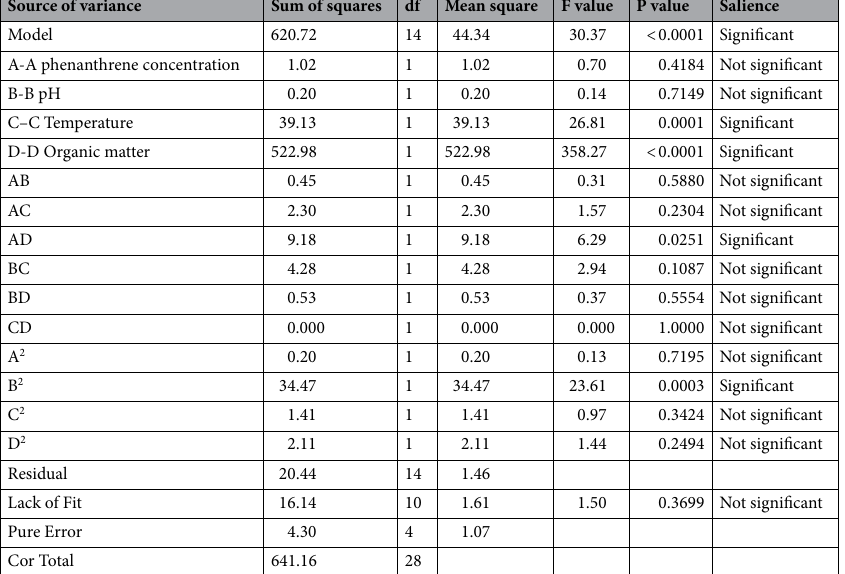
Table 8. Analysis of variance results of silts optimization experiment.